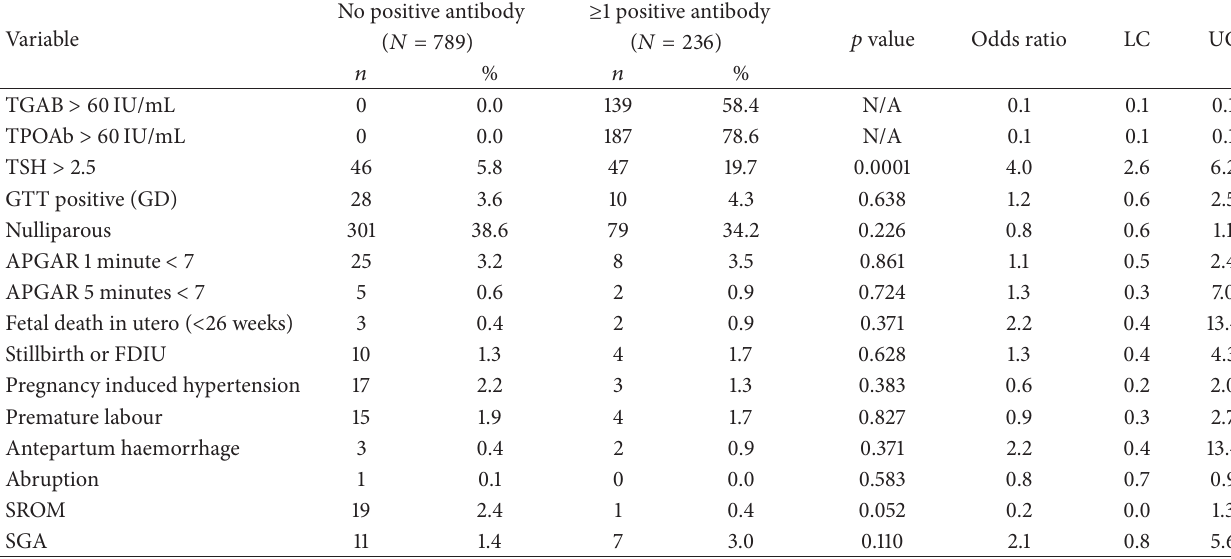
Table 2: A comparison of pregnancy outcomes in women with and without detectable circulating thyroid antibodies.